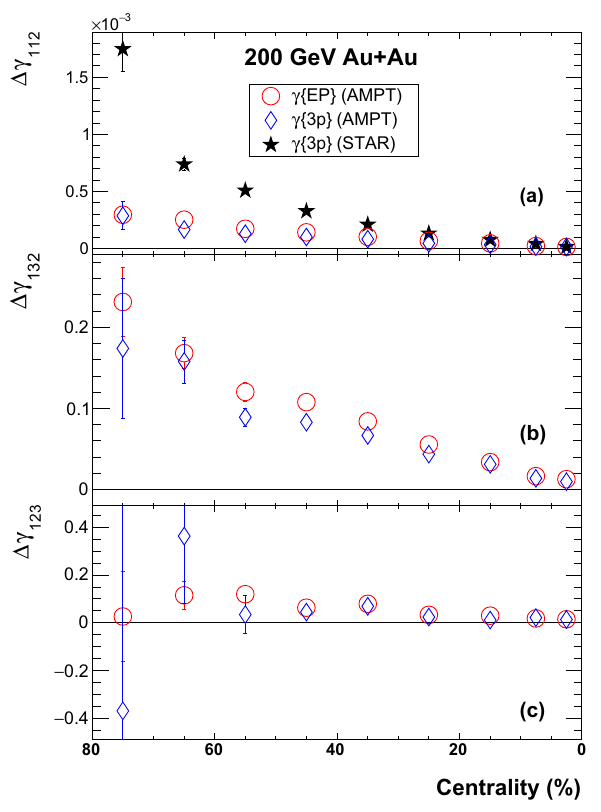
Fig. 4 Centrality dependence of (cid:8)γ 112 (upper), (cid:8)γ 132 (middle) and (cid:8)γ 123 (lower) from AMPT in Au+Au collisions at Both event plane and 3-particle approaches are displayed. STAR data of (cid:8)γ 112 [15] are also shown in panel (a) for comparison denoted by the double bracket